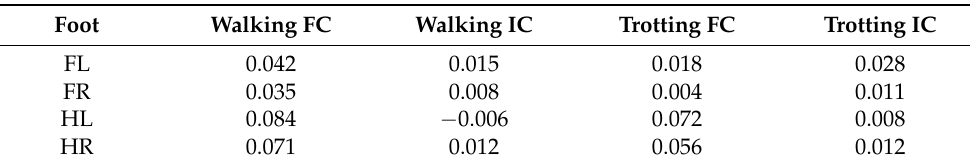
Table 1. The mean error (seconds) for the initial and final contacts during both the walking and trotting gaits of each leg.